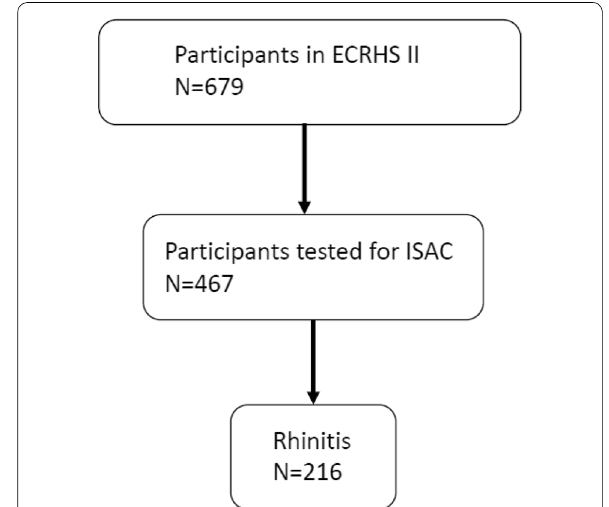
Fig. 1 Flow chart for the inclusion of